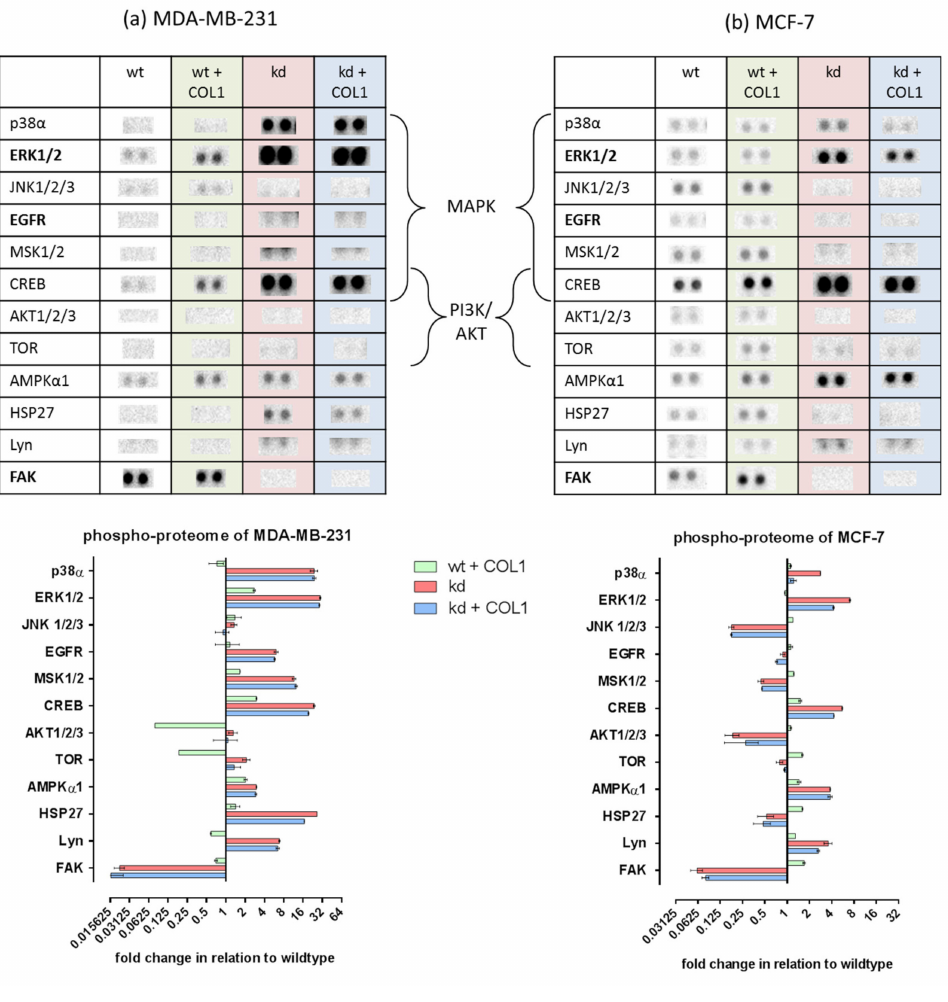
Figure 1. Data of a human phospho-kinase proteome profiler array of MDA-MB-231 ( a ) and MCF-7 ( b ) human breast cancer cells. The impact of collagen type 1 (COL1, green), as well as the absence (knockdown, kd) of ITGB1 (red) and COL1 binding in the absence of β 1 -integrins (blue) in reference to wildtype (wt) cells (black, basis line = 1). The intensities of the phosphorylated kinases were derived by pixel density analysis of the respective arrays shown above and are outlined in a log2 manner ( n = 1). Highlighted are both main survival pathways mitogen-activated protein kinase (MAPK) and phosphoinositide 3-kinase / protein kinase B (PI3K /